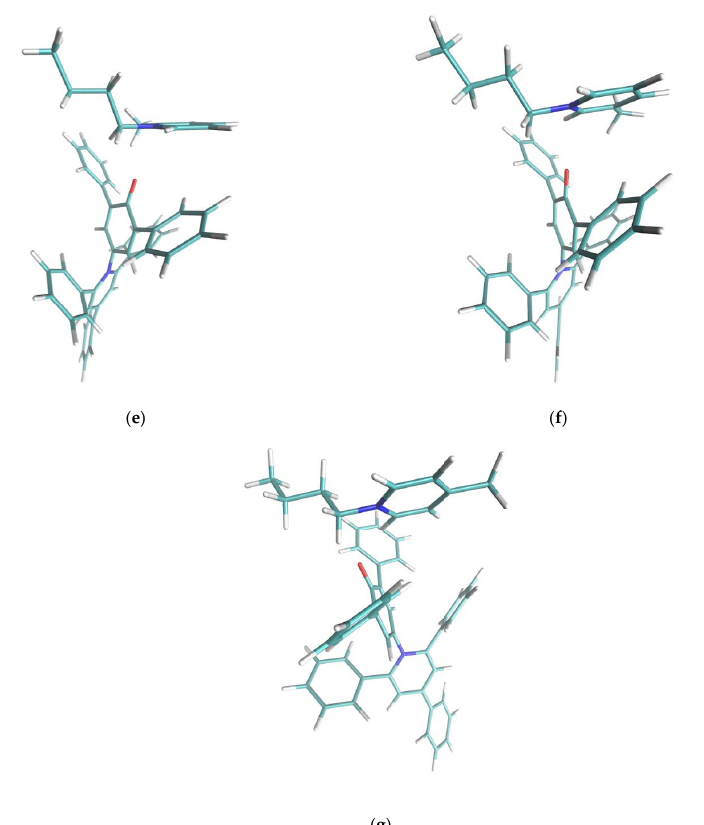
Figure 5. Cation-dye spatial arrangements for some of the cations studied in this paper. ( a ) NaphC 1 Im, ( b ) TOMP, ( c ) C 4 C 1 Im, ( d ) C 4 Im-C 6 -C 4 Im, ( e ) o-C 4 Pic, ( f ) m-C 4 Pic, ( g ) p-C 4 Pic. In the case of the sterically hindered TOMP cation ( b ), the size and the absence of orbital of the π kind did not allow the specific interaction described in this paper. Flat imidazolium- or pyridinium-based aromatic compounds ( a , c – g ) could approach the oxygen moiety at the center of the Reichardt’s Dye pocket more efficiently. In the case of the three picoline isomers ( e – g ), when the methyl substituent was nearby the positively charged center (ortho and meta), it forced a different interaction, weakening the effect. The sidechains that presented an aromatic π system ( a , d ) stacked efficiently on one of the two lateral phenylic groups of the dye molecule. In the case of the dicationic system ( d ), steric hindrance did not allow for the simultaneous interaction of both the positive centers with the phenolic oxygen: one interacted, and the other acted as sidechain. Small sidechains ( c , g ) on imidazolium did not affect the position and orientation of the cation with respect to the dye molecule.